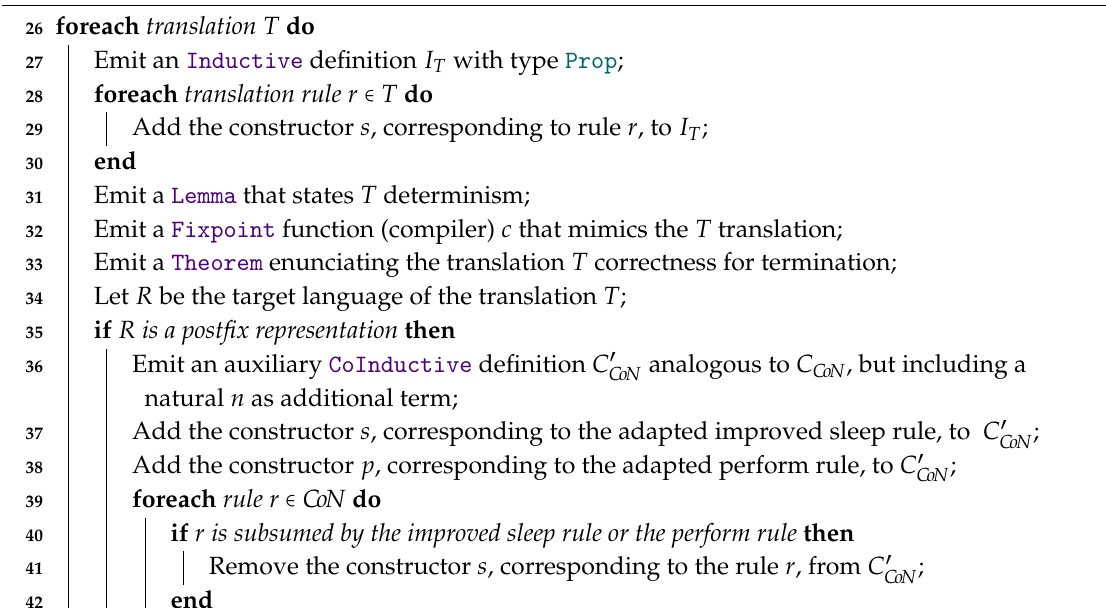
Algorithm 1: Translation of a Compiler Definition to Coq (second